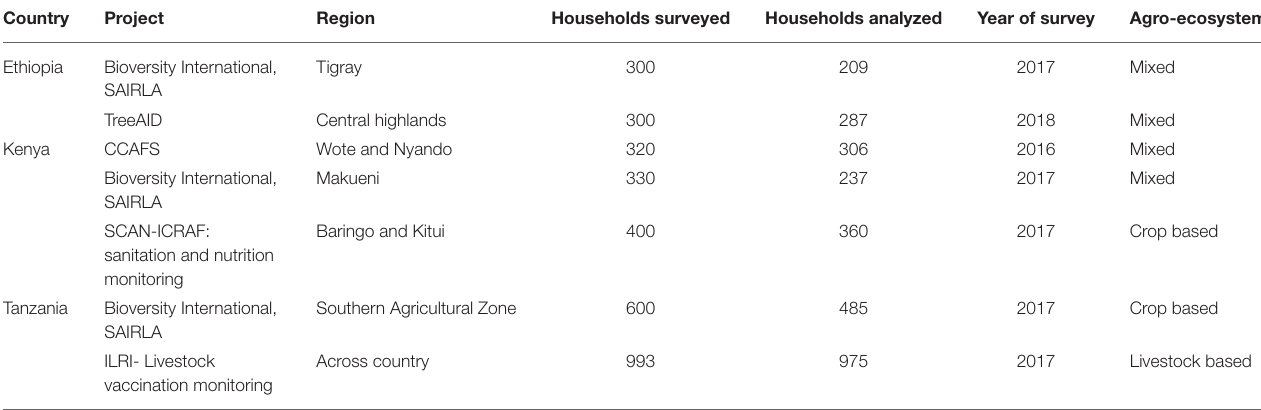
TABLE 1 | RHoMIS household surveys used in this